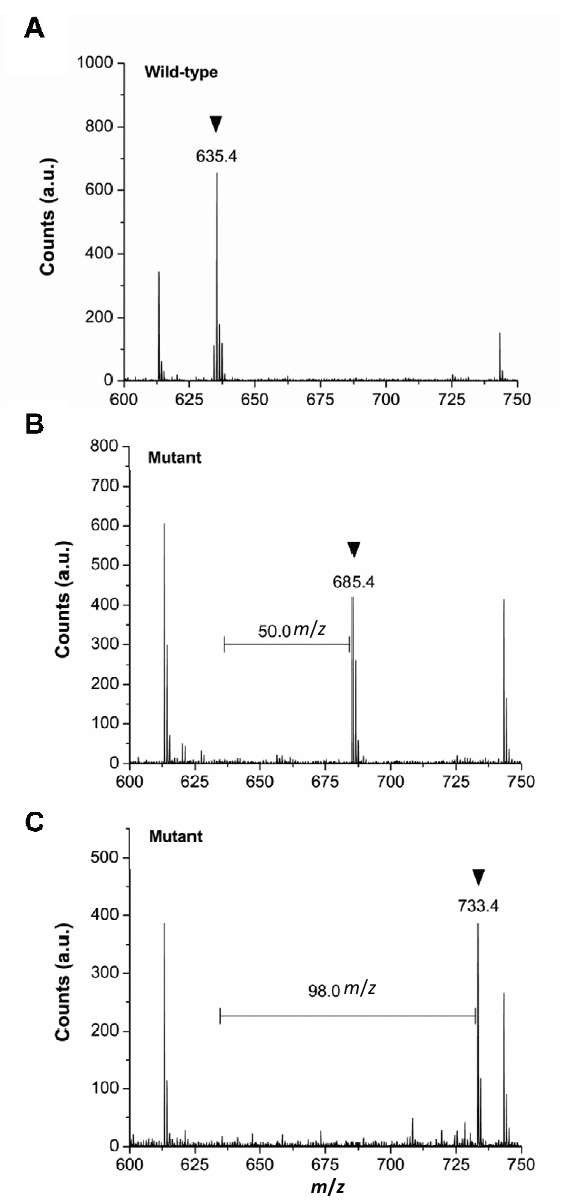
Figure 1. Confirmation of in vivo 2Nal incorporation by MALDI-TOF/MS analysis. The MS spectra of a tryptic digest (residues 133–147) for ( A ) mDHFR WT ; ( B ) mDHFR F134Z ; and ( C ) mDHFR V135Z . The peak corresponding to the 2Nal-containing digest is indicated by the arrow ( B , C ). The counterpart mDHFR WT fragment with the native residue is marked by an arrow ( A ). The residue numbering corresponds to PDB ID: 2W3M. The horizontal bar indicates the mass difference between the 2Nal-containing fragment and corresponding mDHFR WT fragment with the native residue. a.u. denotes arbitrary